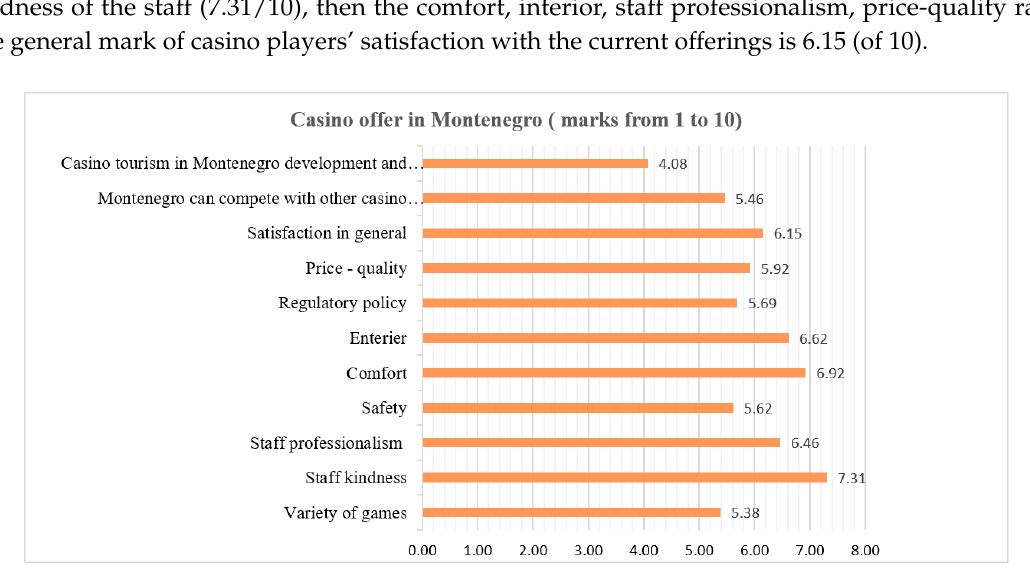
Figure 2. Interview results. Source: Authors.